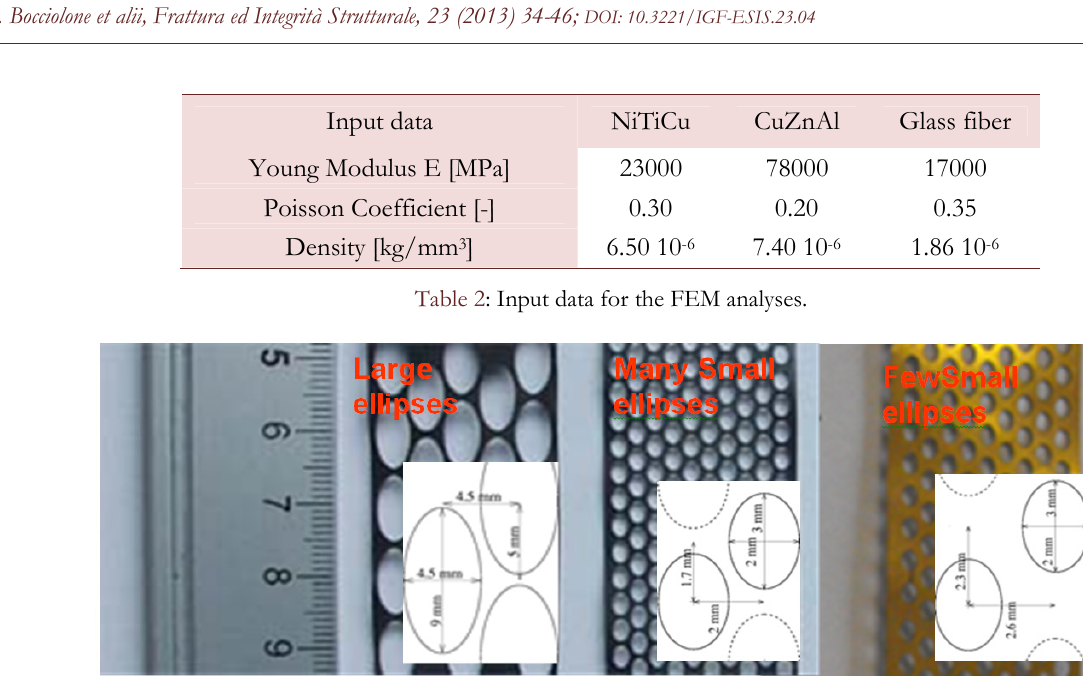
Figure 10: Thin sheets following laser micro-cutting with three different patterns, having a different SMA surface/total surface ratio. Three different patterns of thin SMA sheets, characterized by the same elliptical shape, but having a different hole surface/SMA surface ratio are proposed (Fig. 10).